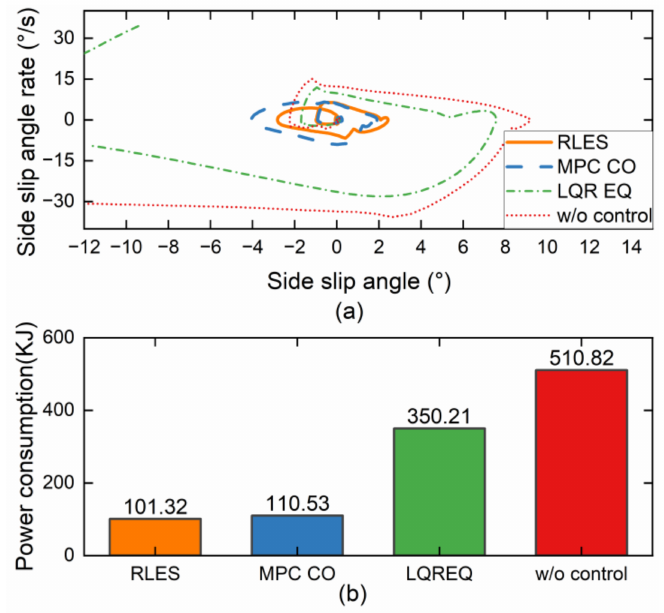
Figure 7. Simulation results on slippery road. ( a ) Phase trajectory portrait; ( b ) motor power consumption. Table 2. Performance indicators in DLC maneuver on slippery